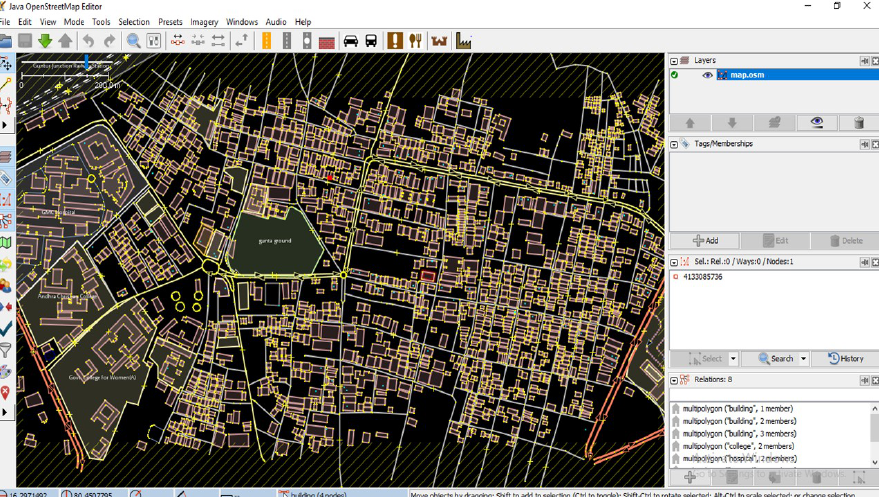
Figure 10. Java open street map